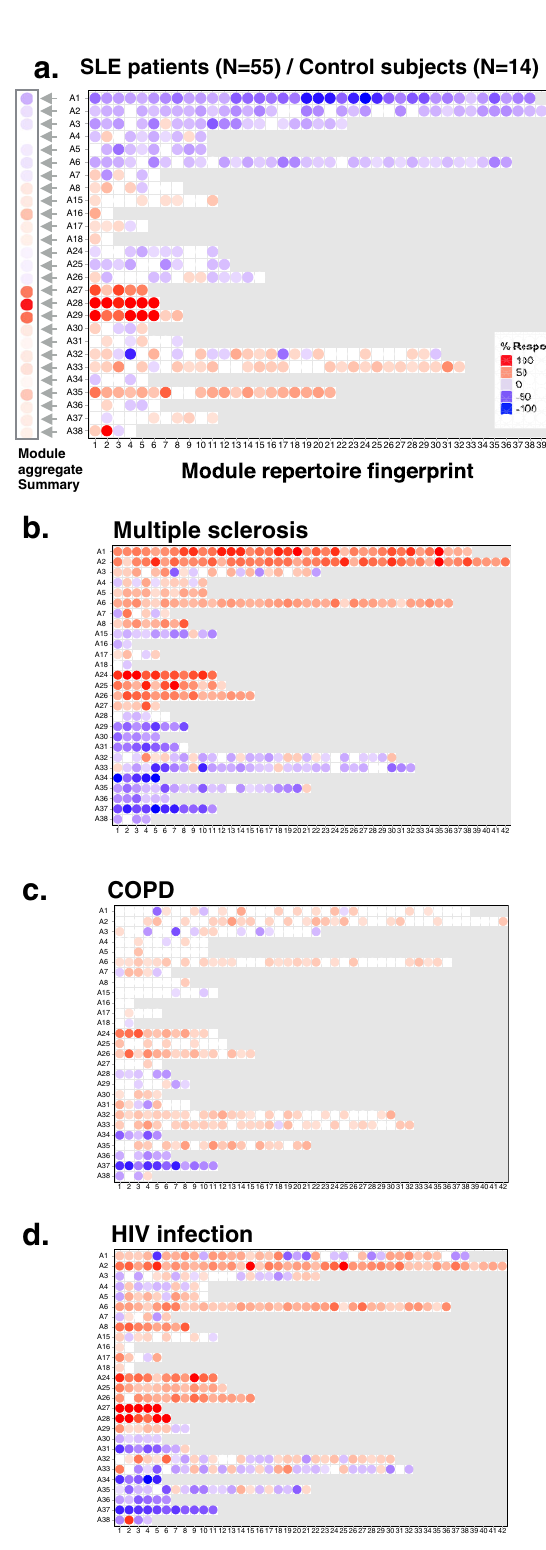
information for BloodGen3 modules and made it accessible via